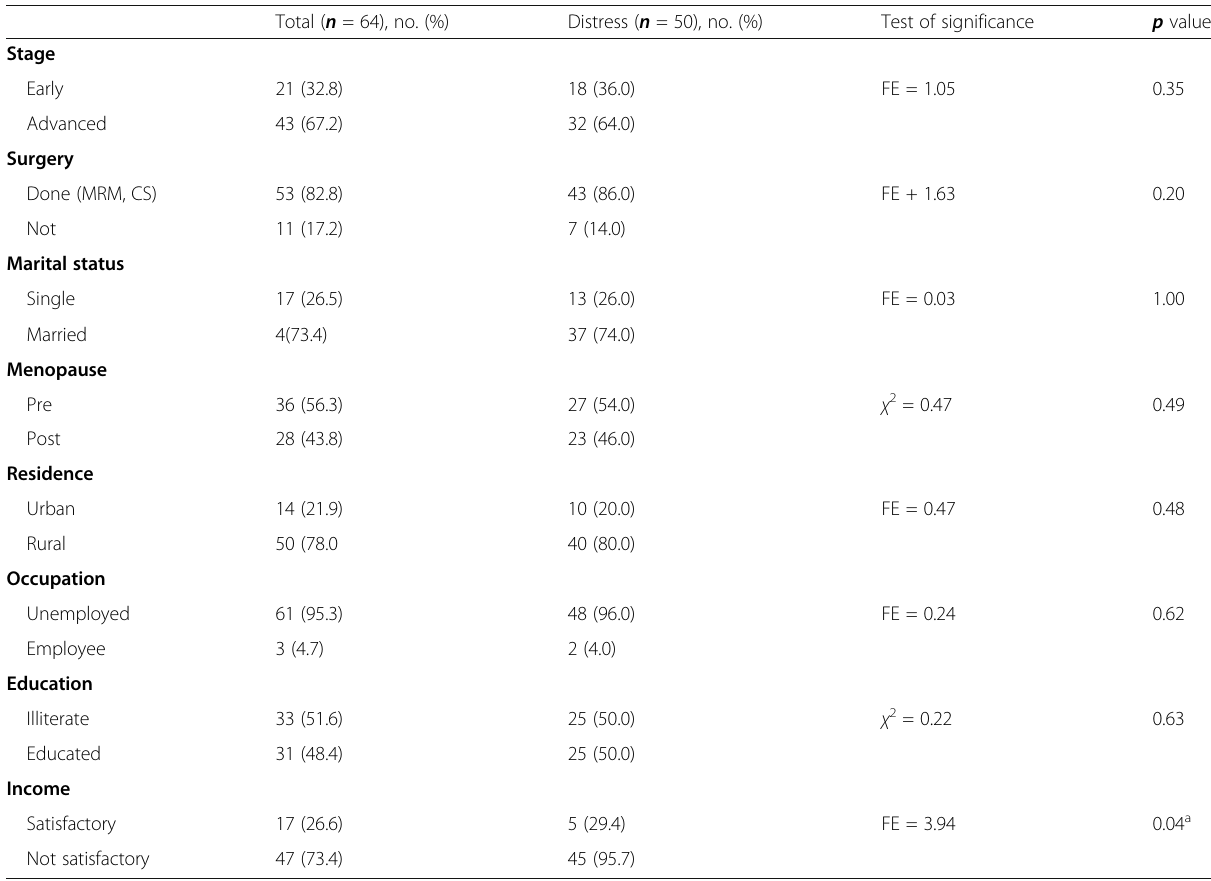
Table 5 Relationship between the total number of cases and patients with distress as regarding patient ’ s and disease ’ s